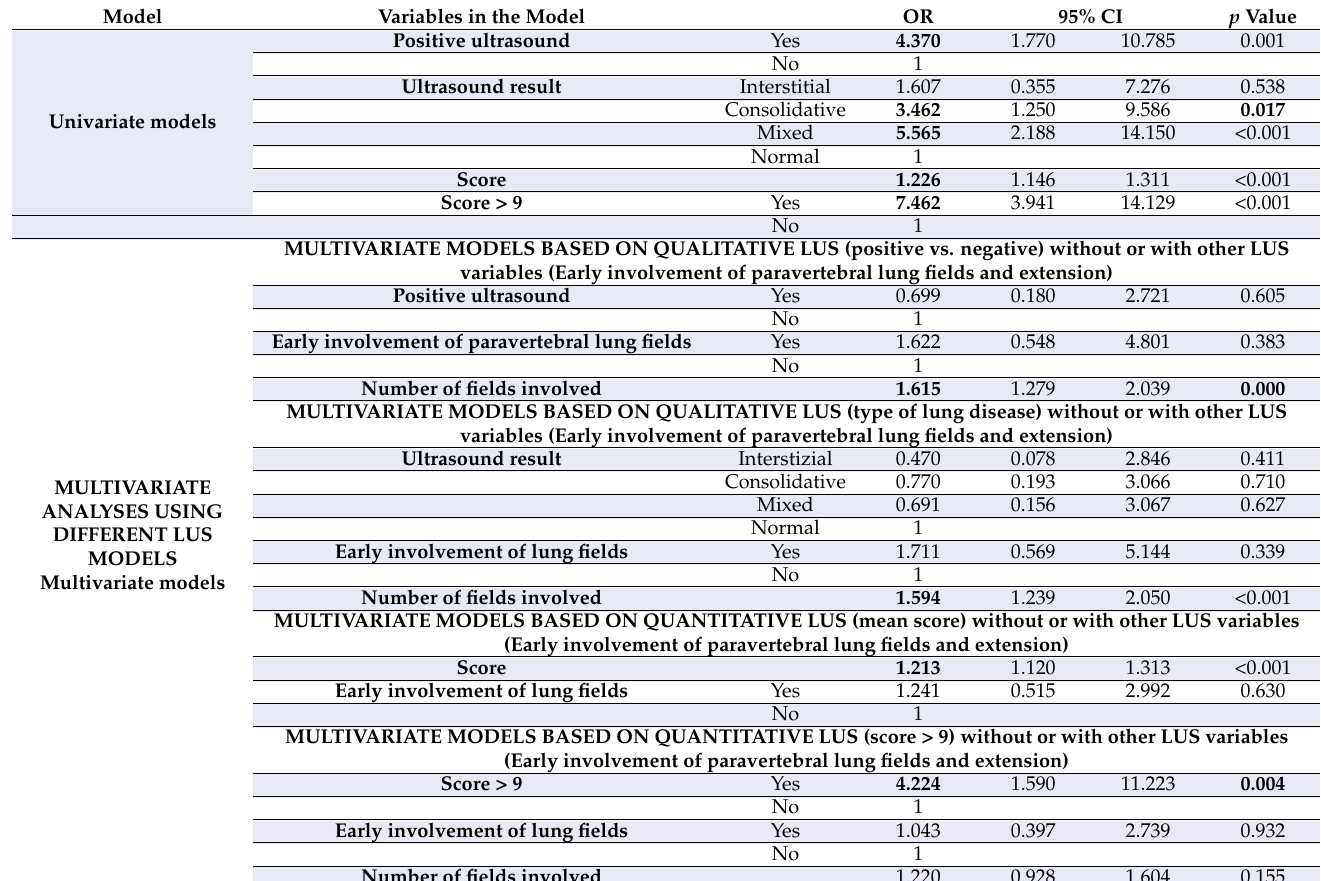
Table 4. Multivariate models showing correlation of the different lung ultrasound models at baseline with bronchiolitis severity.